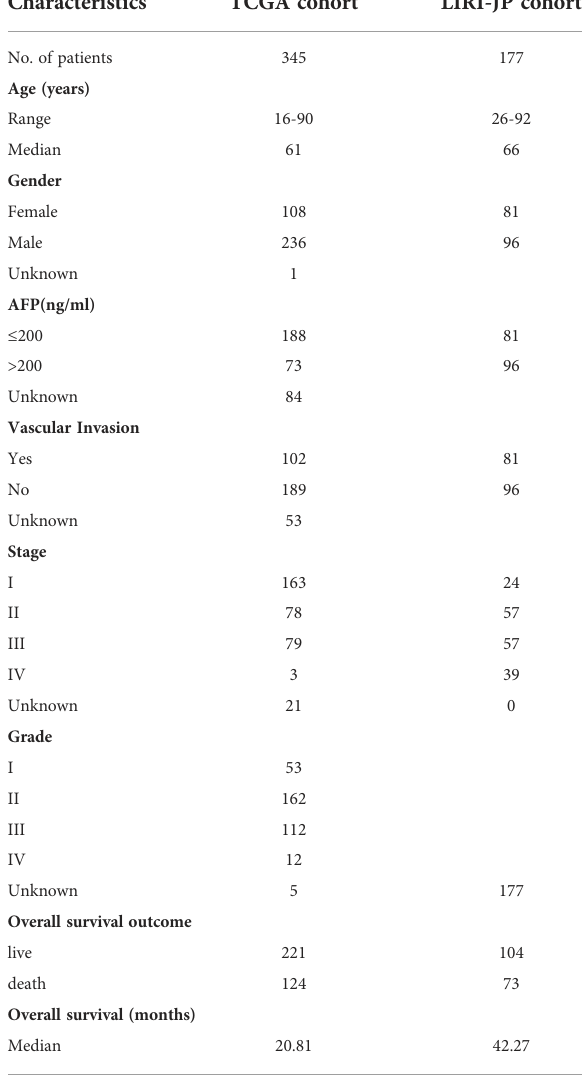
TABLE 1 Clinical characteristics of patients with liver cancer in two datasets.